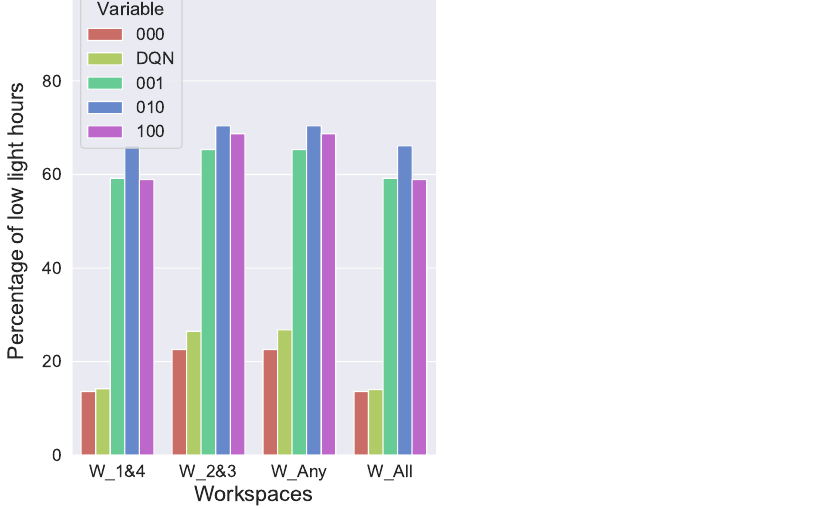
Figure 11. Low light hours at all the workspaces with clearest combinations of EC